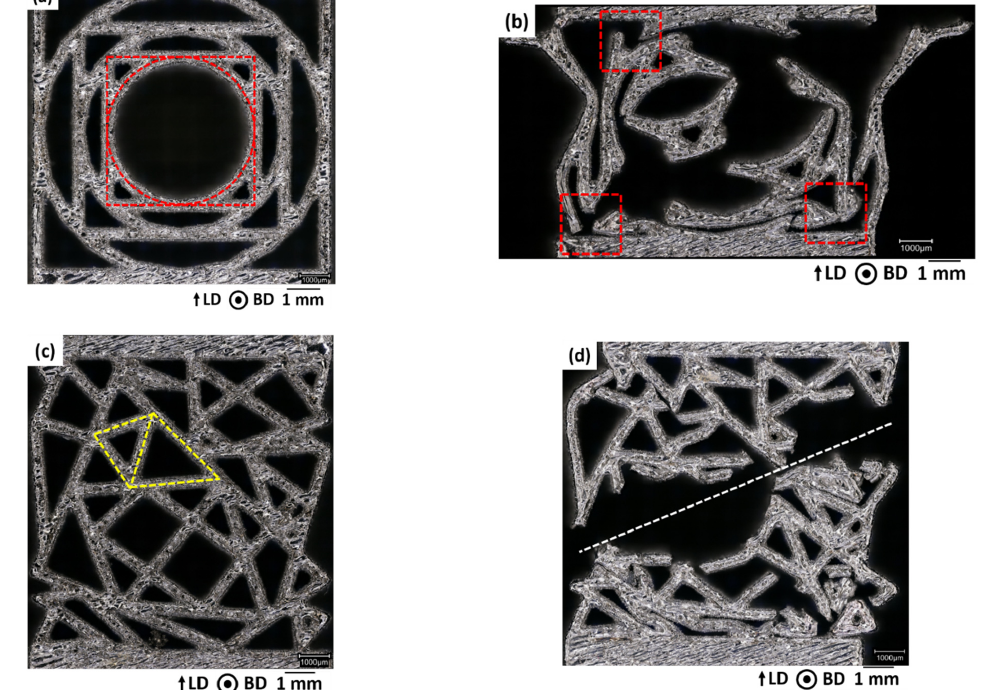
Figure 2. Optical micrographs of the ( a , c ) nested cellular solid; ( b , d ) non-nested cellular solid; ( a , b ) before; and ( c , d ) after 50% strain. BD is the build direction and LD is the loading direction. Red and yellow lines mark the unit cell of the nested and non-nested cellular solid, respectively. The loading direction along the vertical direction. The build direction is perpendicular to the surface plane in Figure 2. The white line represents the shear fracture plane in Figure